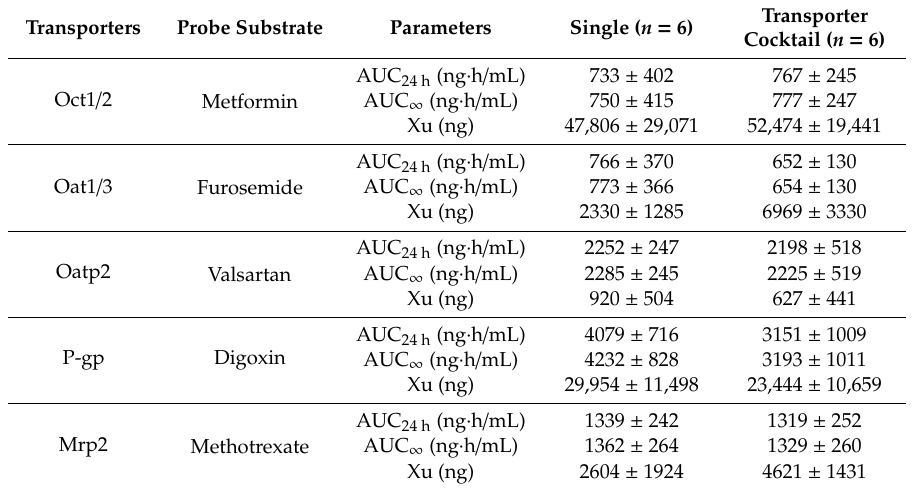
Table 6. The comparison of pharmacokinetic parameters between single and transporter cocktail groups.